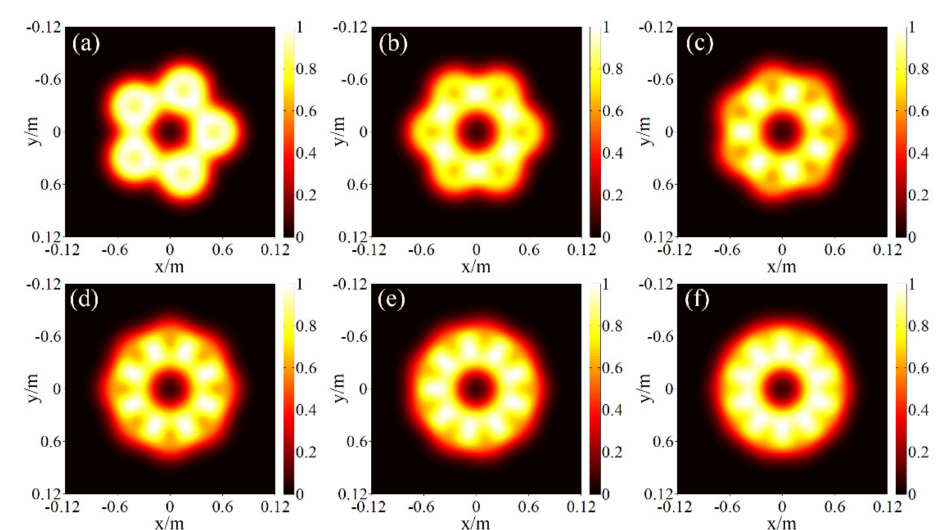
Figure 4. Intensity distributions of the RPLPCV beam array propagated through non-Kolmogorov turbulence for different beamlet numbers: ( a ) N = 5; ( b ) N = 6; ( c ) N = 7; ( d ) N = 8; ( e ) N = 9; ( f ) N = 10.